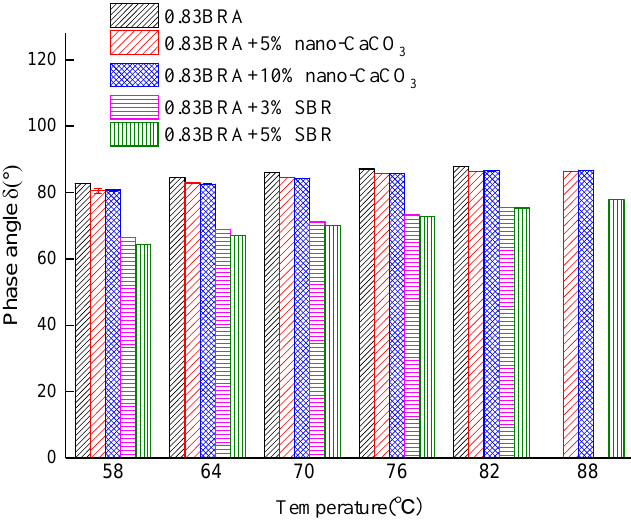
Figure 3. The relationship between phase angle δ and temperature of nano-CaCO 3 /BRA and SBR/BRA compound-modified asphalt.